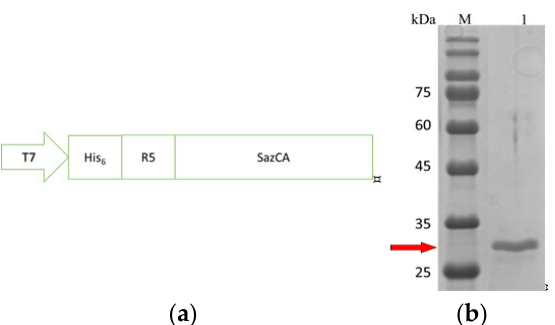
Figure 1. Gene construction and purification of R5-SazCA. ( a ) Schematic of the gene; ( b ) SDS-PAGE; lanes: M, marker; 1, purified R5-SazCA.